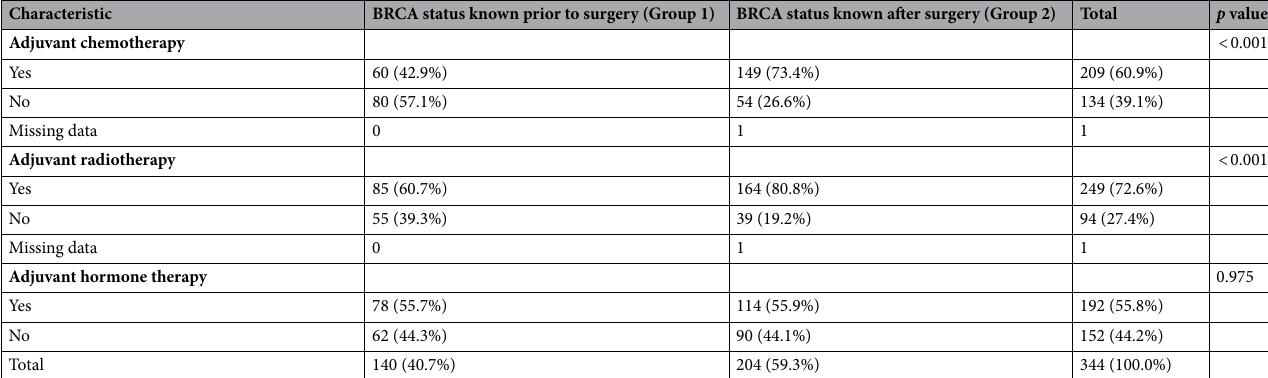
Table 1. Clinicopathological and treatment characteristics of patients. HR hormone receptor, HER2 human epidermal growth factor receptor 2. a Pathologic T stage and pathologic N stage include post neoadjuvant therapy pathological category.